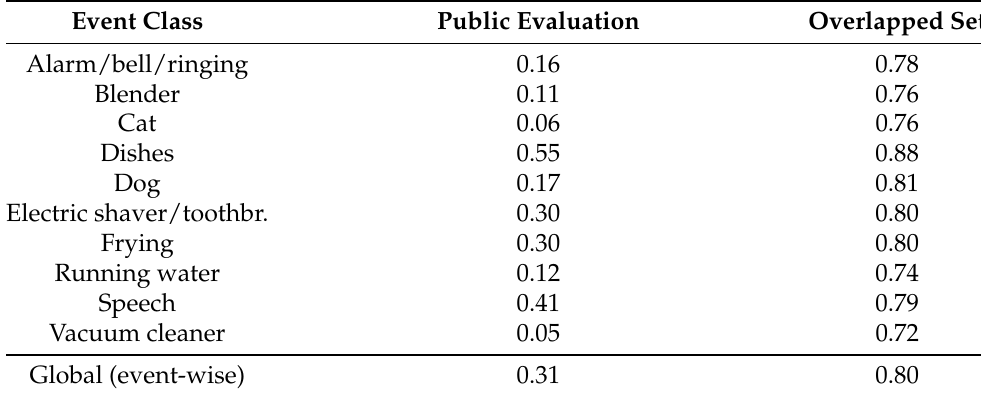
Table 4. Value of overlap ratio ( ρ ) per class in each dataset. The overlap level of a class in a dataset is computed as the average ρ across all the events belonging to that class, where for each event ρ is the ratio between its overlapped time and its total length. The global ρ of each dataset is computed as the event-wise